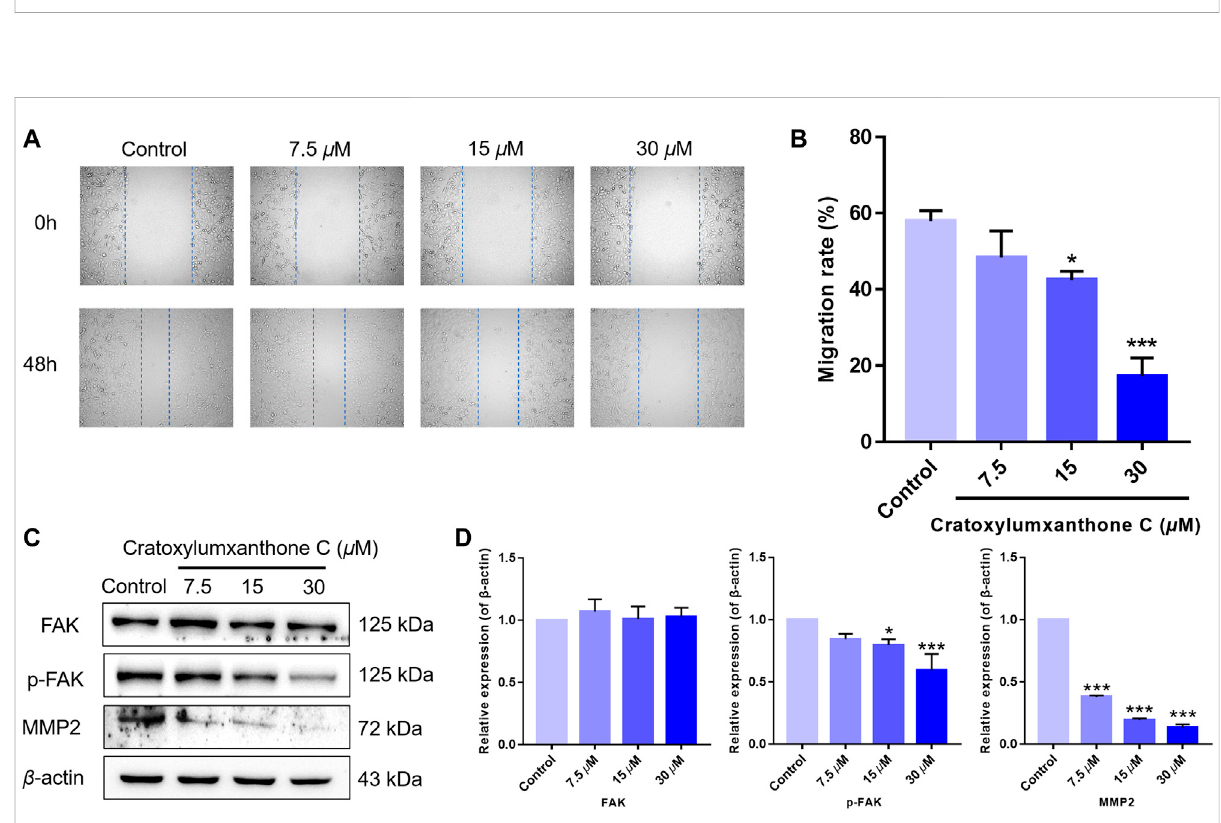
FIGURE 6 Cratoxylumxanthone C regulated STAT3 signaling pathway and apoptosis-related proteins. (A) Western blotting analysis was conducted to evaluatetheeffectsofcratoxylumxanthoneContheexpressionofSTAT3,p-STAT3,Mcl-1,cyclinD1,Bcl-2,caspase-3,andcaspase-9. (B) Histogram of the protein relative expression level compared with control group. The results are expressed as means ± SD. * p < 0.05, ** p < 0.01 and *** p < 0.001 versus control group.